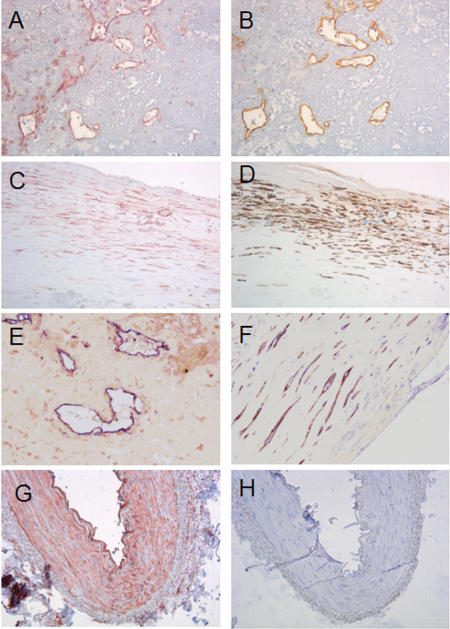
Cav-1 immunohistochemistry.A, C: Cav-1 staining on carotid plaques (red, 200x magnification). B: Endothelial staining (CD34, brown) on a consecutive section of A showing co-localization of Cav-1 and endothelium. D: Alpha-actin smooth muscle cell staining (brown) on a consecutive section of C, showing co-localization of Cav-1 and smooth muscle cells. E: Double-staining of Cav-1(red) and CD34 (blue),( 200X magnification). F: Double staining of Cav-1 (blue) and Alpha-actin smooth muscle cell sataining (red) ( 200X magnification). G: Cav-1 staining on a mammary artery, showing staining throughout the intima, media and adventitia. (100x magnification). H: Negative control of Cav-1 staining in a consecutive section of G, avoiding the primary antibody. Sections were counterstained with haemotoxylin except the double-stained sections (E and F) .